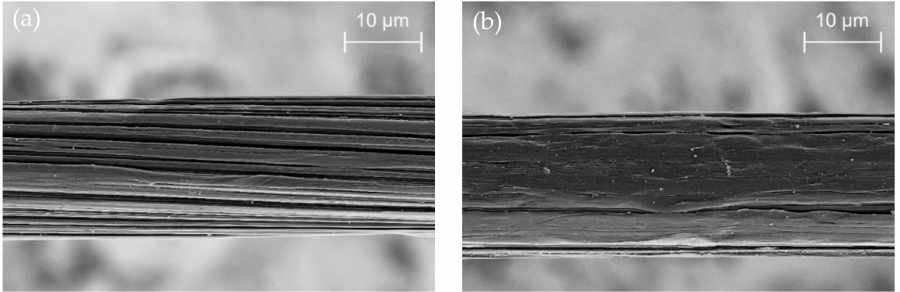
Figure 1. Examples of surface structures of ultra-high molecular weight polyethylene (UHMWPE) fibers, ( a ) high surface roughness by fibrillated surface resulting from high draw ratios during fiber manufacturing, ( b ) part of the surface with less pronounced fibrillation and reduced